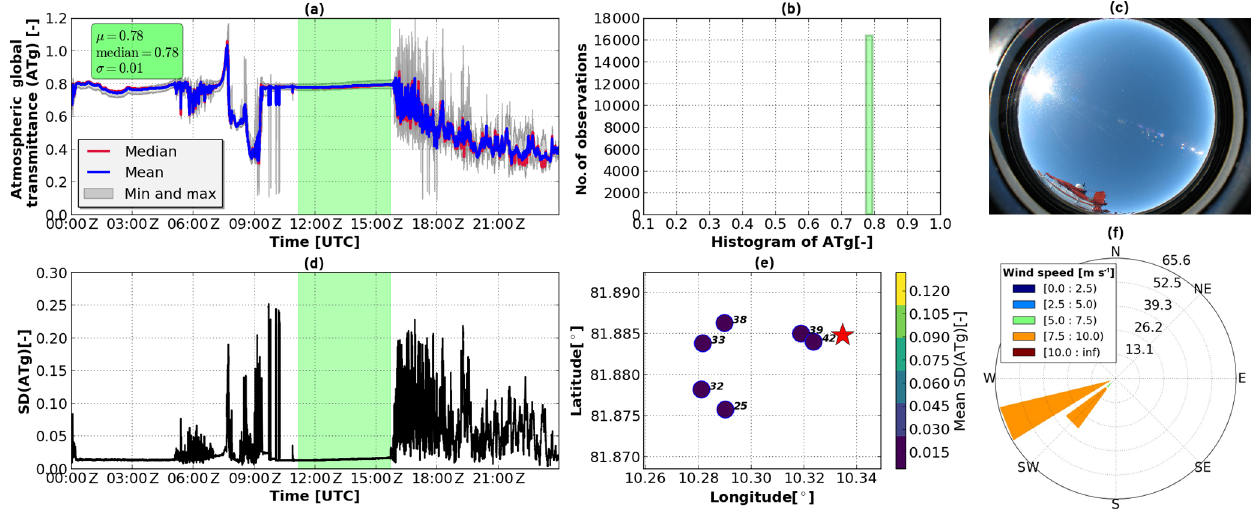
Figure 6. Overview of the cloudless case: panel (a) shows the time series of atmospheric global transmittance (ATg), and the green-shaded background marks the cloudless period (10 June 2017, 11:10–15:43Z). (b) Histogram of global transmittance for cloudless conditions. (c) Photograph from the all-sky camera at 13:51:44Z. (d) Time series of the inter-station standard deviation (SD) of ATg based on all functional stations. (e) Map of the stations showing the temporal SD for individual stations, while the red star marks the position of Polarstern . (f) Wind rose for the selected